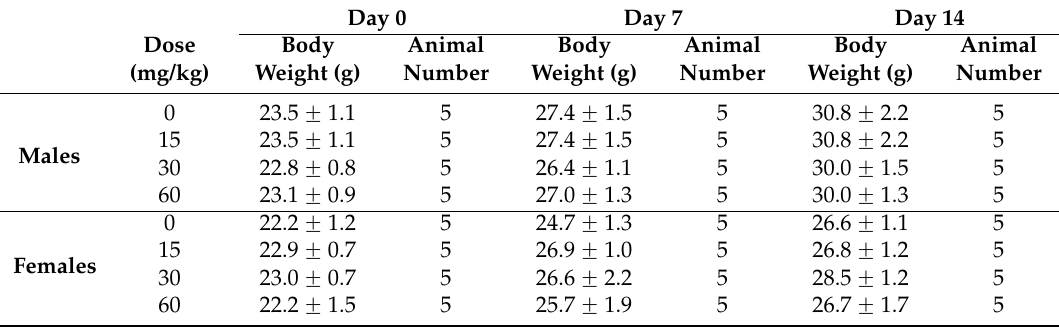
Effects of SalB-Rg1 on body weight and survival number with seven-day repeated dose